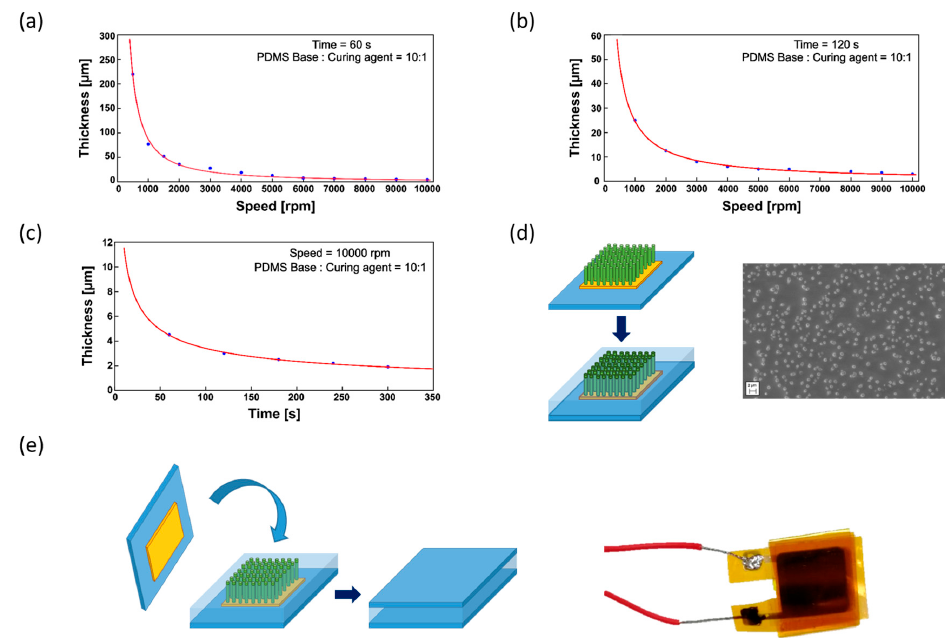
Figure 8. Fabrication of the ZnO-based pressure sensor from the growth of ZnO NRs on polyimide substrate. ( a ) Encapsulation of ZnO nanorods into PDMS: spinning curves of PDMS layer thickness obtained after 60 s spinning at different spinning speeds (exponential fitting R² = 0.9951), and ( b ) 120 s (exponential fitting R² = 0.9954). ( c ) Variation of the thickness with the spinning time at 10,000 rpm speed (exponential fitting R² = 0.9969). ( d ) SEM image of the ZnO rods encapsulated in the polymeric matrix after dilution of PDMS in Hexane, obtained after 150 s spinning at 6000 rpm. ( e ) Final device.